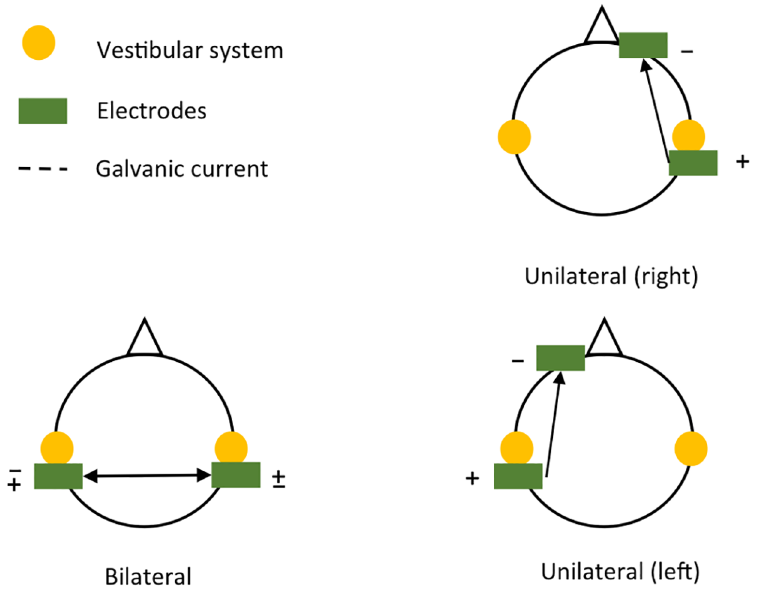
Fig 2. The three types of galvanic stimulations